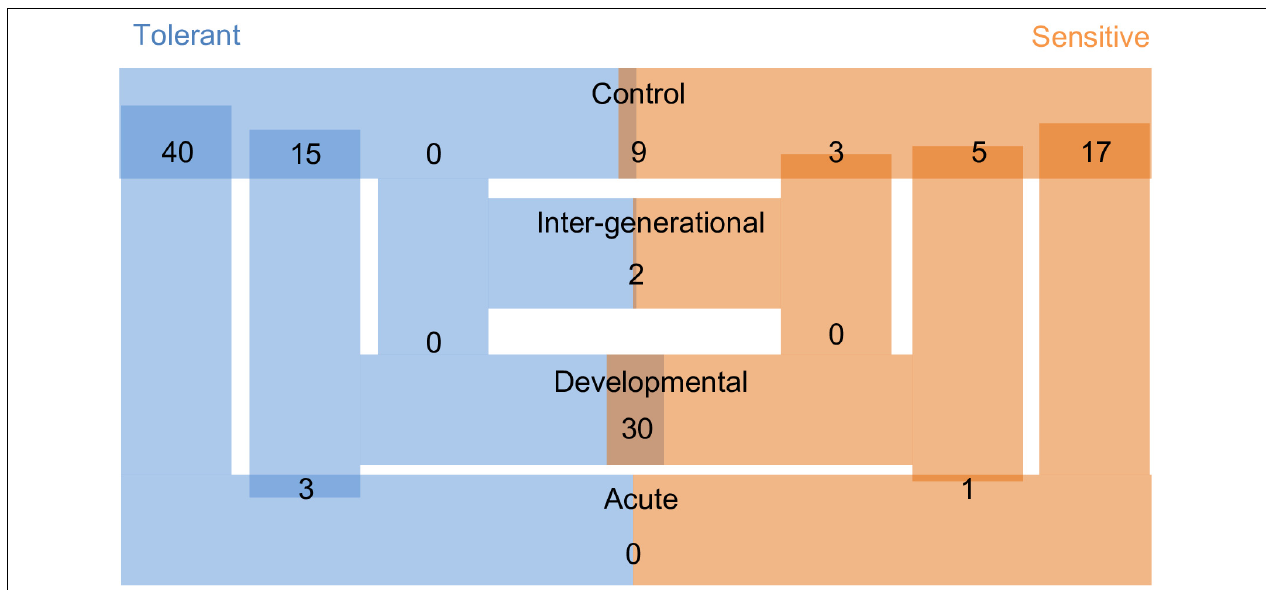
FIGURE 3 | Number of differentially accumulated proteins (DAPs) across all comparisons between CO 2 treatments and parental phenotypes. Larger overlap of bars represent a higher number of DAPs. ‘Tolerant’ and ‘Sensitive’ refers to the behavioral parental phenotypes. Control, Acute, Developmental and Inter-generational refer to each of the experimental CO 2 conditions ( Figure 1